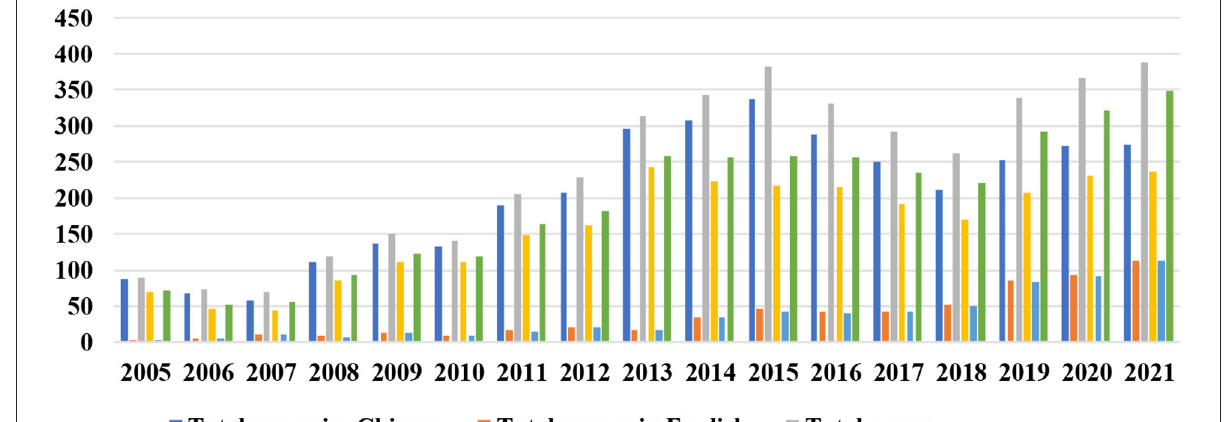
FIGURE2 The trend of papers published by Chinese publicly traded pharmaceutical companies during the period 2005–2021.